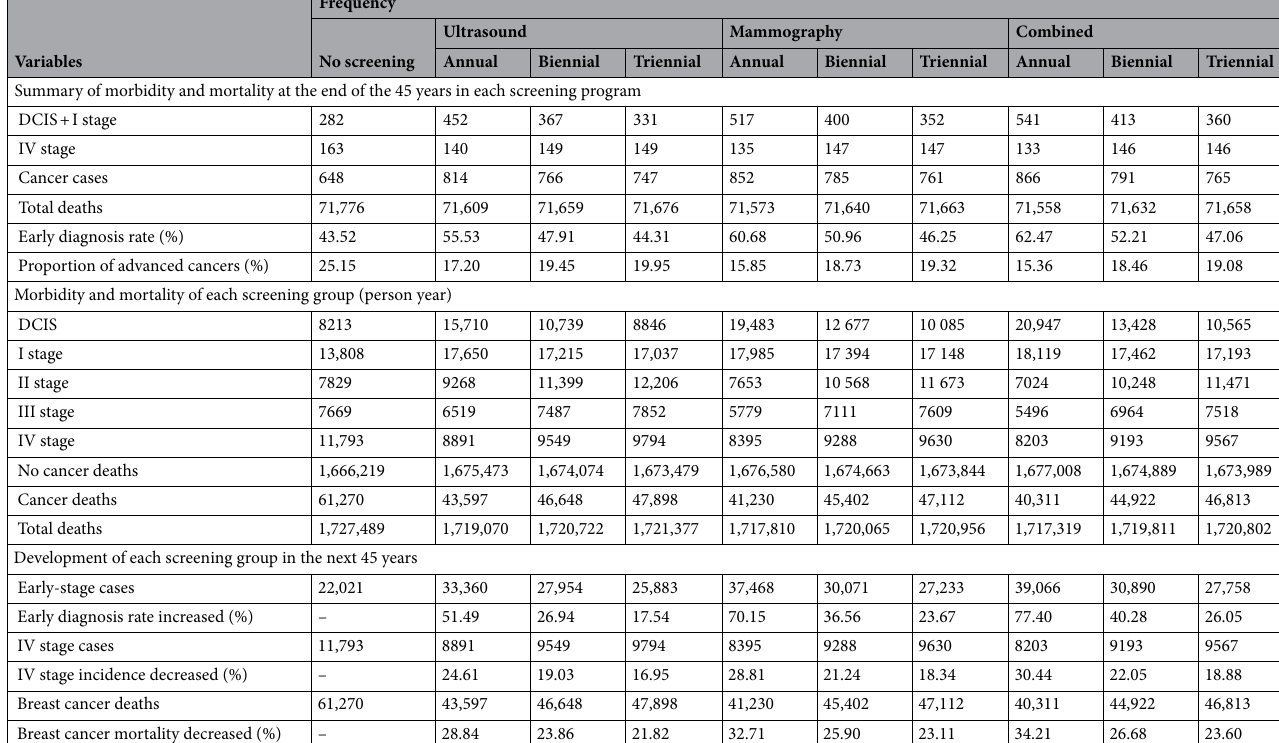
Table 4. The comparison of the effect among screening and no screening